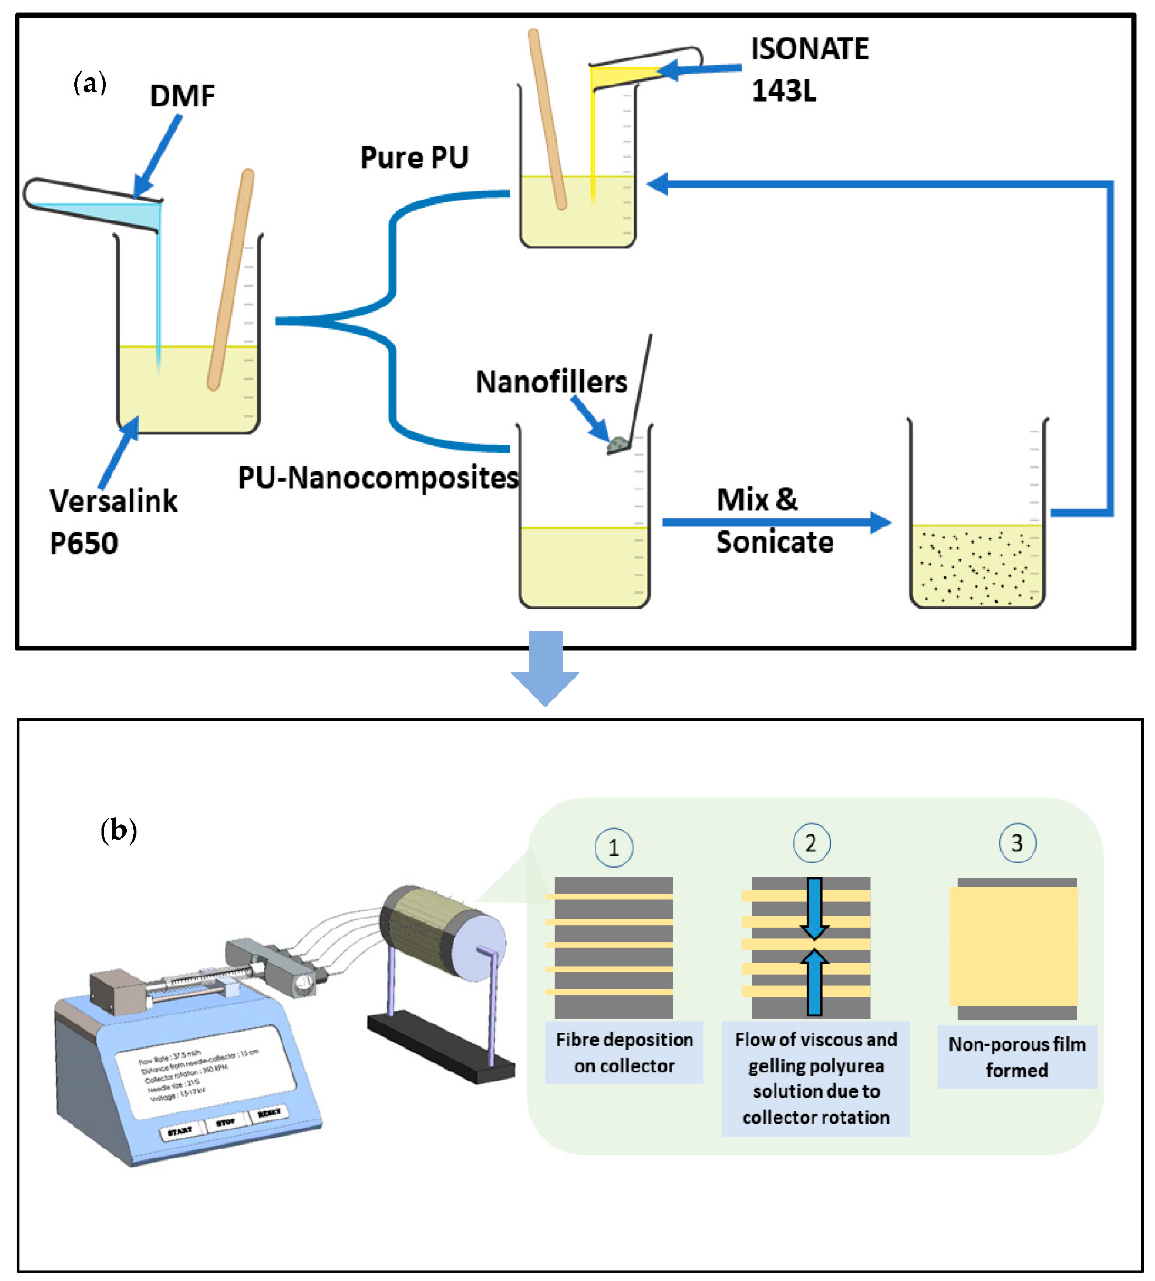
Figure 1. Process of preparation of polyurea nanocomposites thin films. ( a ) Solution preparation; ( b ) electrospinning pro- cess.